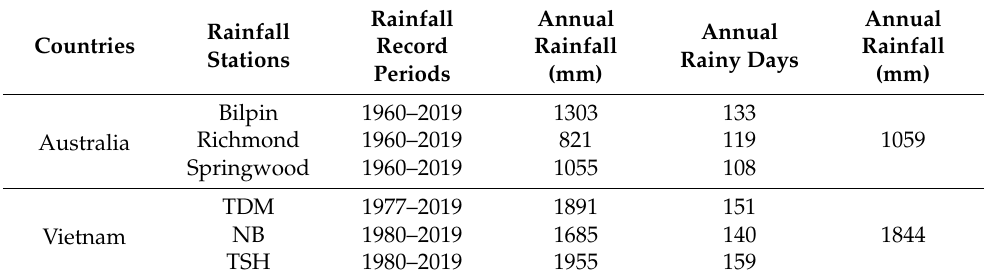
Figure 1. Locations of selected rainfall stations. ( a ) Australia rainfall stations: Bilpin, Richmond and Springwood; ( b ) Vietnam rainfall stations: TDM, TSH and NB. Source: Google Maps www.google. com/maps (accessed on 2 January 2022). Table 1. Summary of rainfall data of the selected stations in Australia and